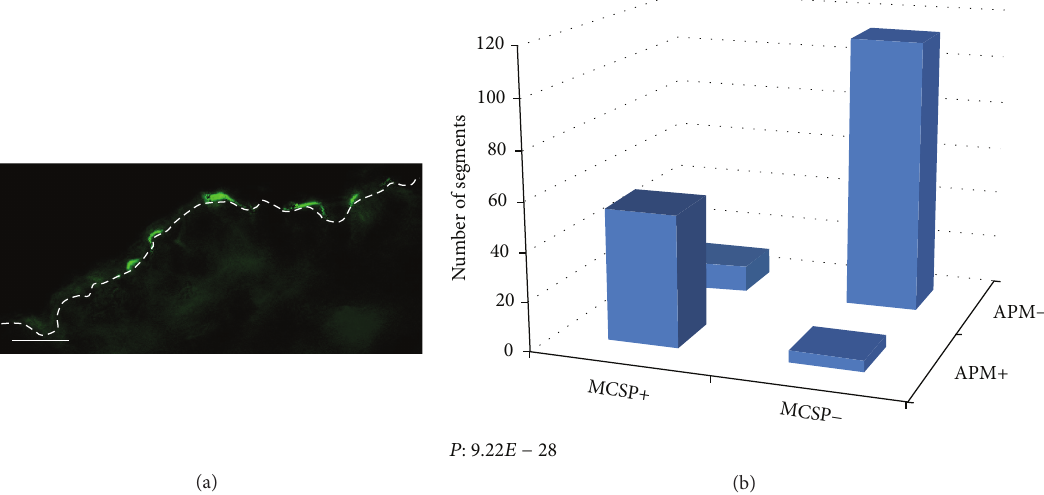
Figure 4: Localization of MCSP in the interfollicular epidermis. Immunofluorescence microscopy showing patterns of expression of MCSP. (a) MCSP (green) demonstrates a heterogeneous expression in the basal epidermis. (b) A strong correlation between phalloidin and MCSP was seen suggesting that cells expressing MCSP in the basal epidermis are located in close proximity to the attachments sites of the APM. Scale bar: 100 𝜇 m.